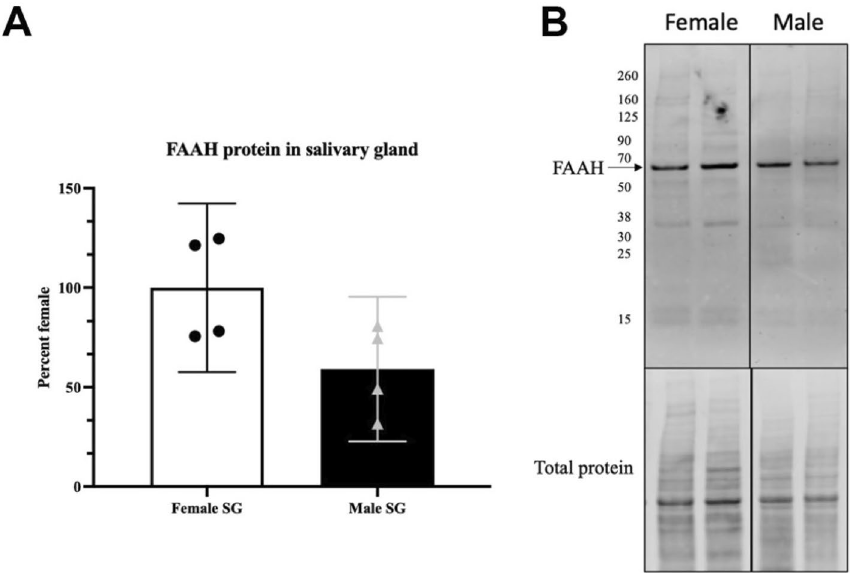
Figure 6. FAAH protein in male vs. female submandibular gland. ( A ) FAAH protein levels in males and females (p = 0.058, student’s t test, n = 4). ( B ) A protein band is detected at the expected molecular weight (~ 63 kDa). Full blot in Supplementary Fig.